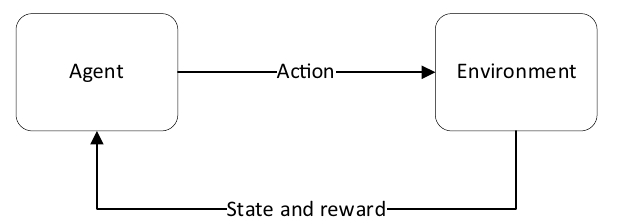
Figure 1. Simple process of reinforcement